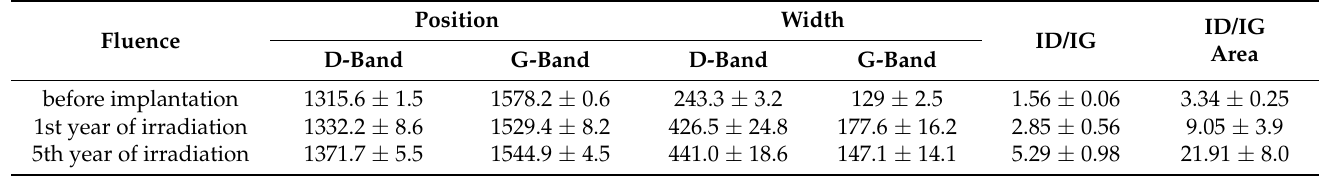
Table 3. The average values obtained from six samples of S-3 p-TRISO IPyC